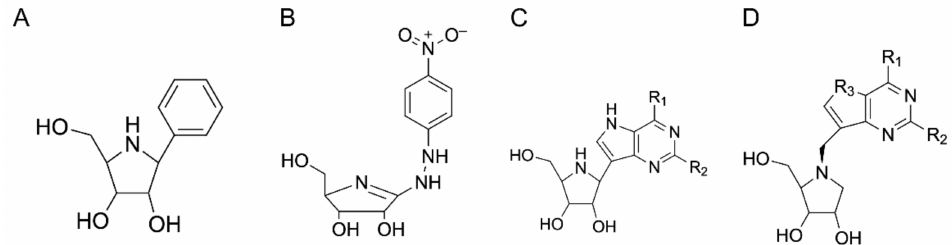
Figure 7. Iminoribitol-based NH inhibitors. ( A ) Substituted phenyliminoribitols are effective, tran- sition state-like inhibitors of the Crithidia IU-NH. ( B ) 4-nitrophenyl riboamidrazone, a nanomolar inhibitor of the C. fasciculata isozyme. ( C ) Immucillins, originally identified as transition